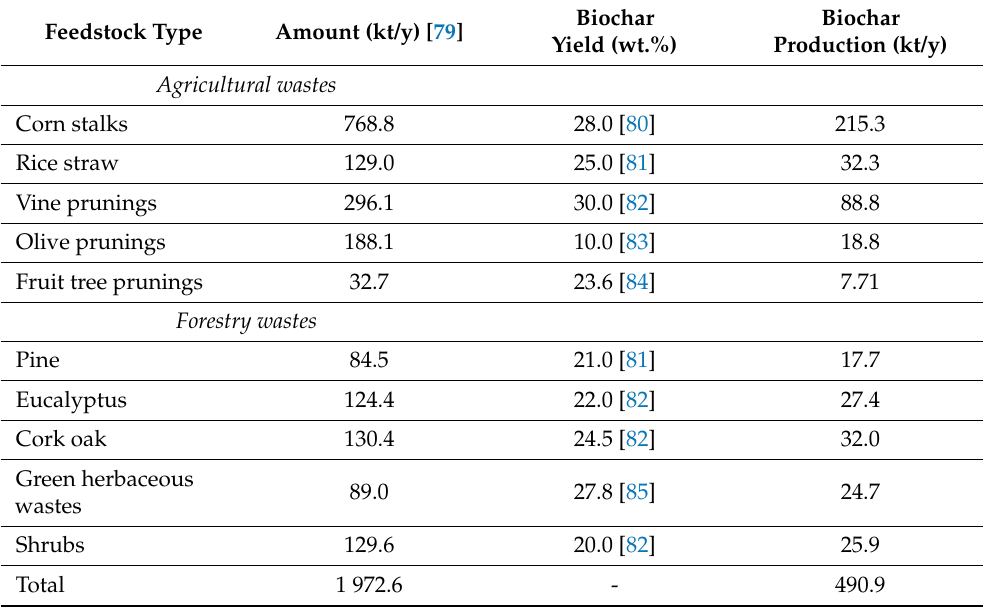
Table 10. Technical biochar potential produced from the slow pyrolysis of the main wastes available in Alentejo.